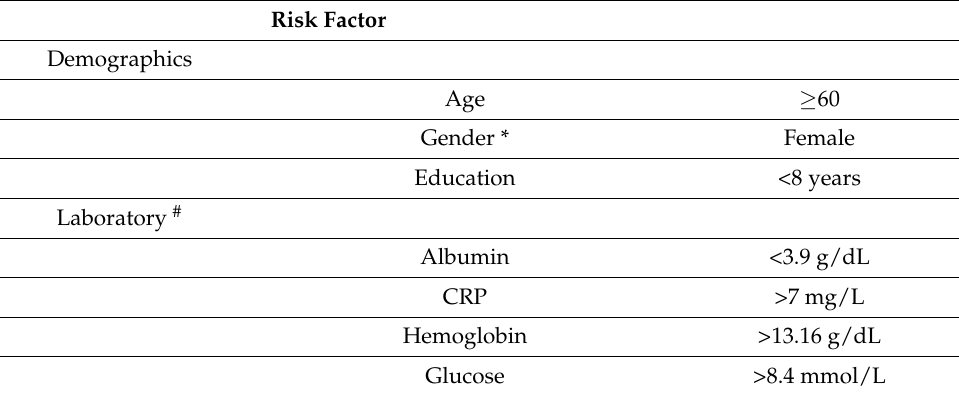
Figure 1. PRISMA flow diagram. Table 1. Clinical record table including the risk factors correlated with POD development at a statistically significant level (cited in ≥ 2 studies).